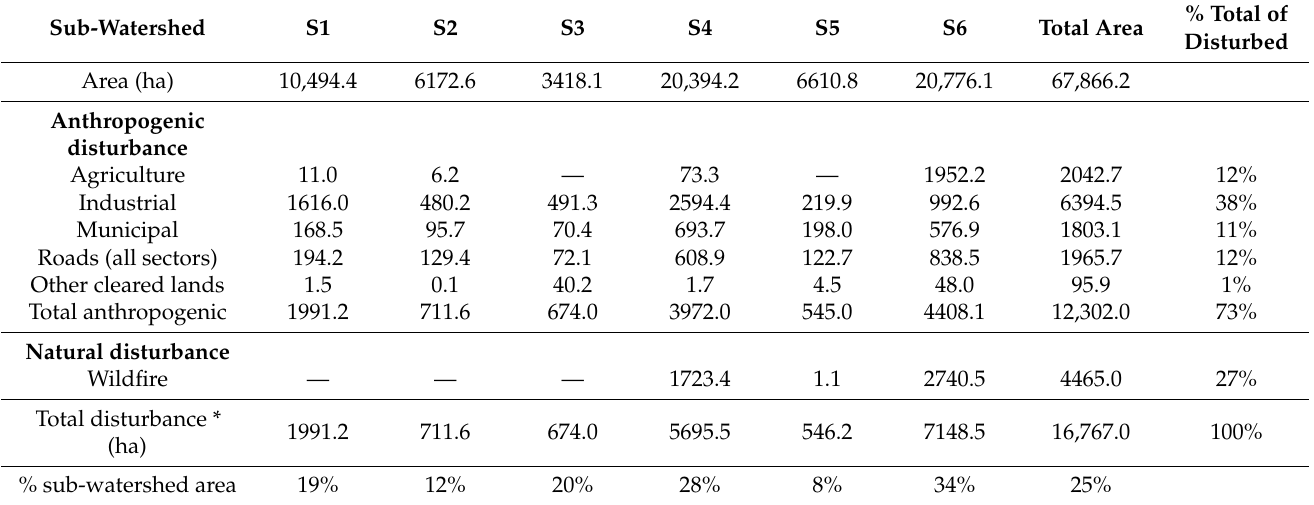
Table 1. Historic anthropogenic and natural land disturbance footprint (to 2016) in Crowsnest River sub-drainage corre- sponding with six downstream sampling locations (Figure